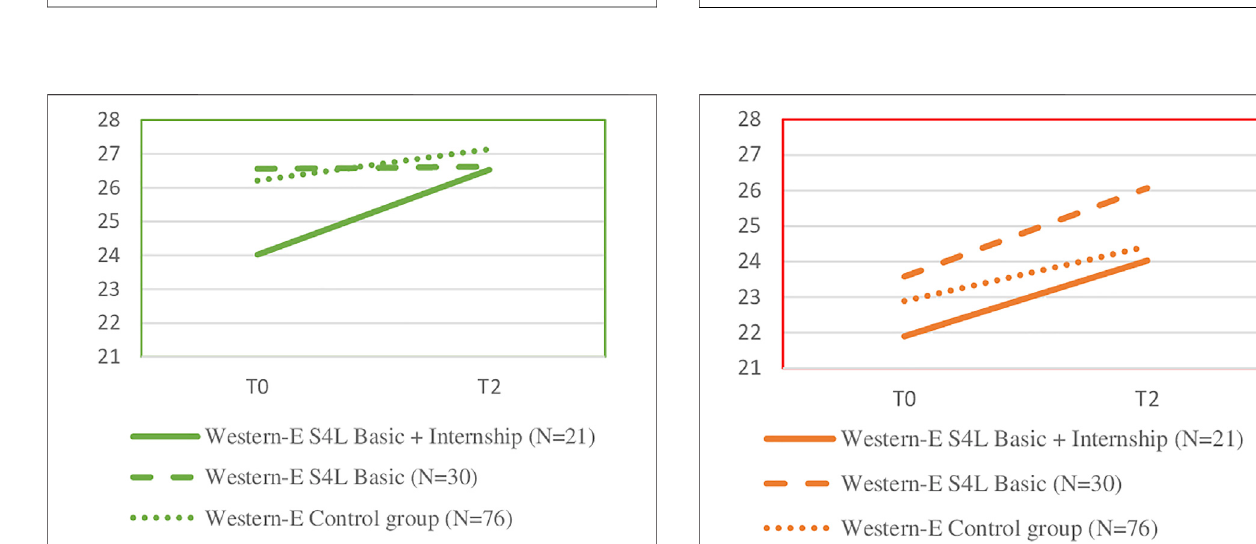
FIGURE 2 | Relationship skills T0 – T2 Non-western students (Means). Note: Non-Western (cid:1) Students who identify themselves as having non- western background (e.g., Turkish, Moroccan, Cape Verdean, Pakistani, or Somali); S4L-basc +internship: Students exposed tothe S4L-basicand the S4L-intership module; S4L-basic: Students exposed to the S4L-basic module alone; Control group: Students in the Waitlist Control group.